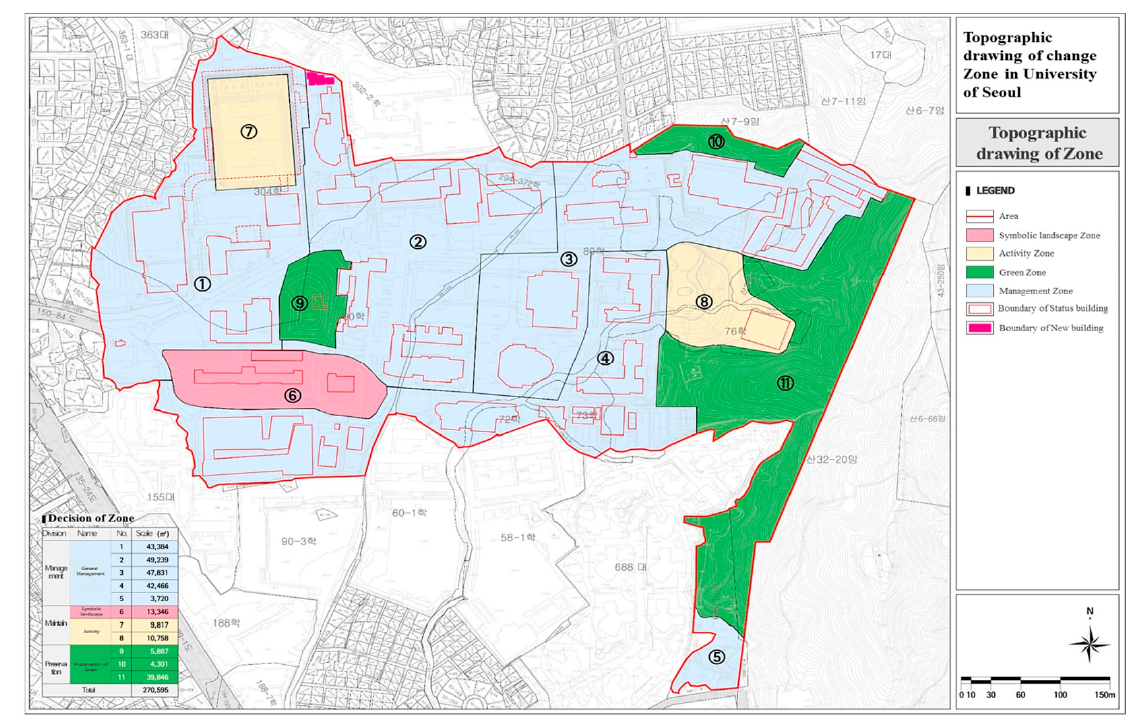
Figure 3. Drawing of the LURM. Source: Seoul Metropolitan Government [69].